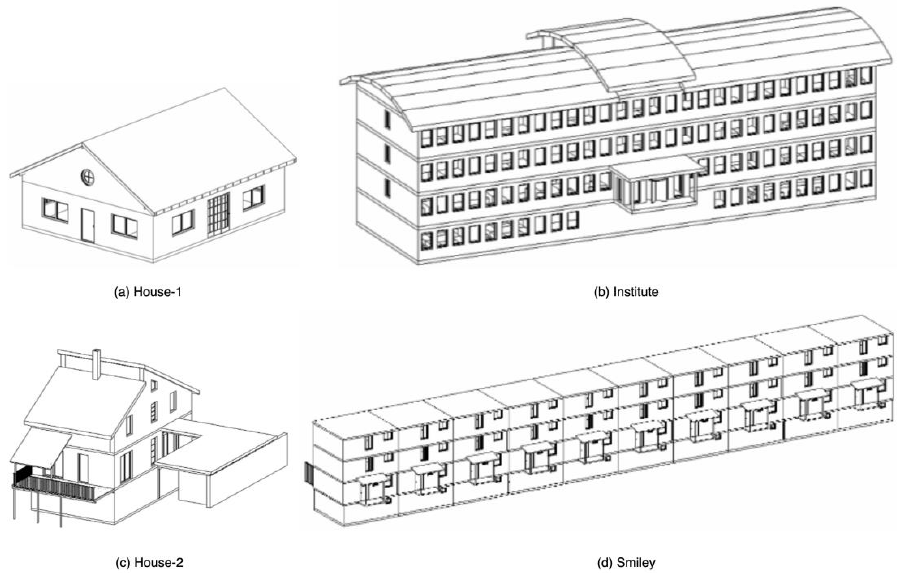
Figure 8. Building models used in this study.